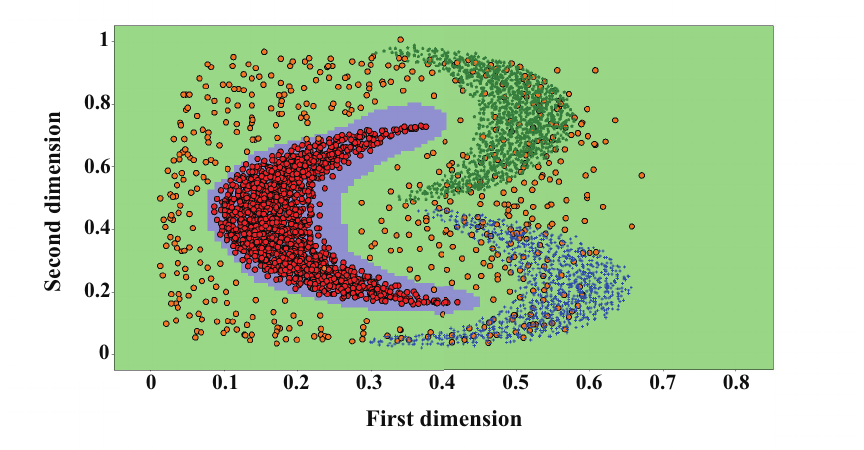
Figure 6. Discriminating space based on the SVM